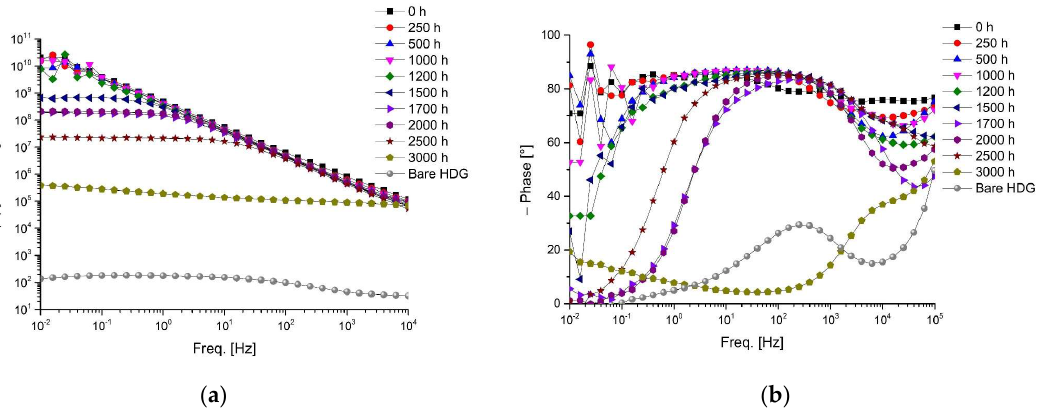
Figure 7. Example of impedance modulus ( a ) and phase angle ( b ) evolution in time for painted HDG steel during the prohesion test.